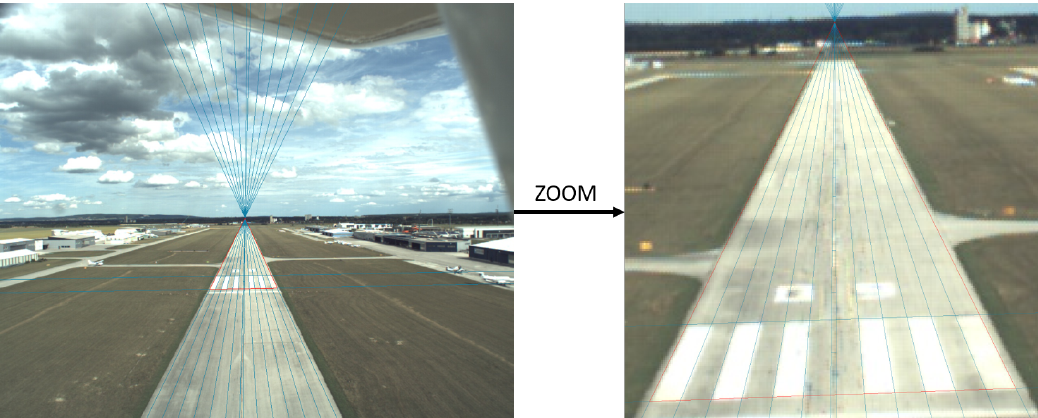
Figure 16. Image taken 100 m from runway threshold. The bar markers perfectly detectable. Runways are not completely flat which can cause inaccuracy in the case of complete runway detection from closer positions <200